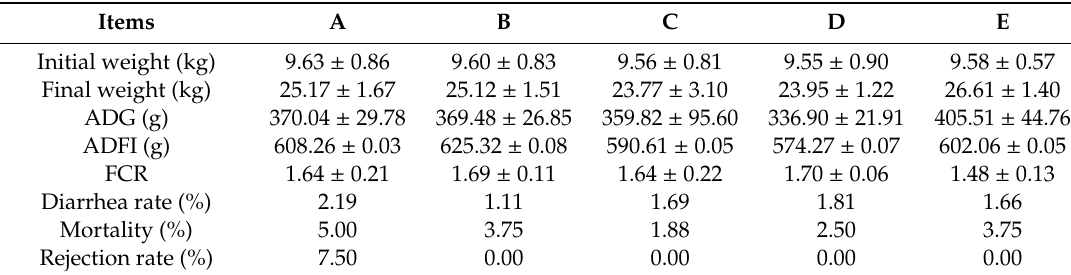
Table 2. E ff ect of CPB on piglet growth performance.